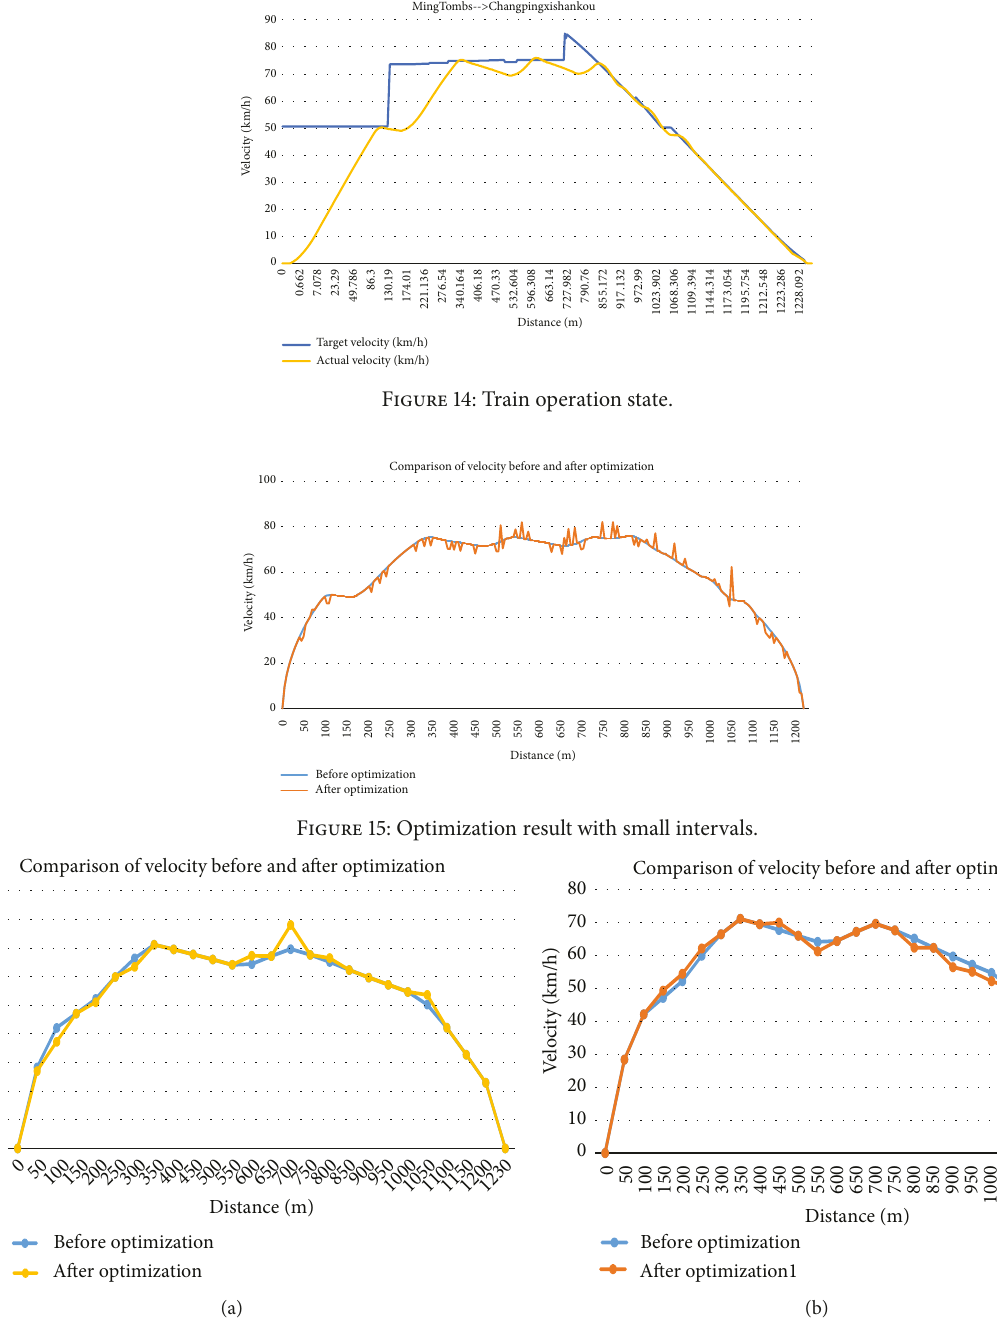
Figure 14: Train operation state.